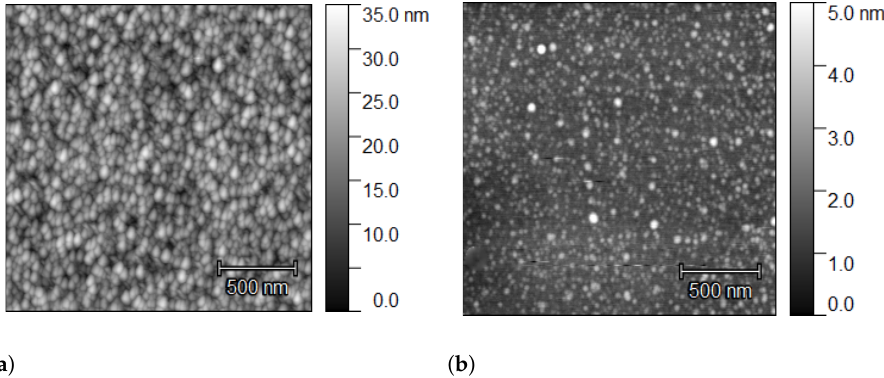
Figure 1. AFM images of TiO 2 films with 80 nm thickness deposited at ( a ) 300 °C (roughness (RMS) = 5 nm, surface area = 4.255 µ m 2 ), ( b ) 150 °C (roughness (RMS) = 0.5 nm, surface area = 4.005 µ m 2 ).